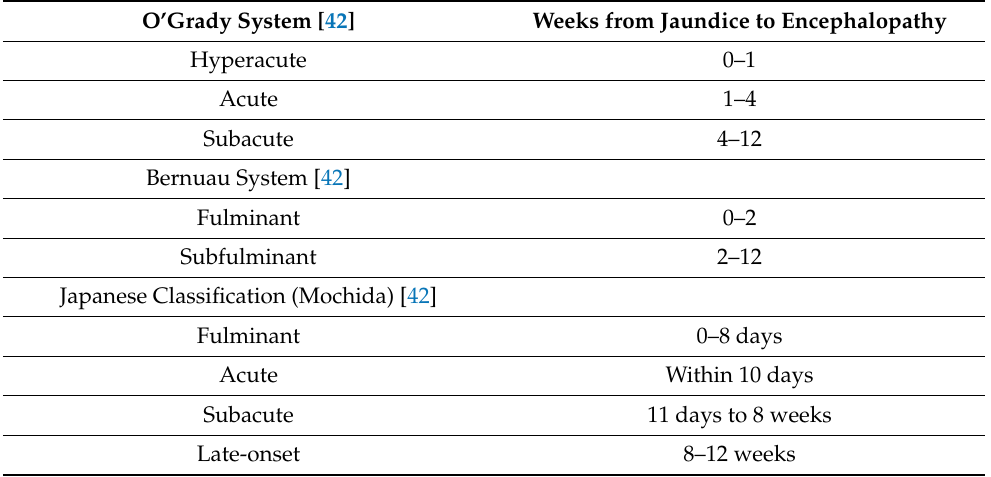
Table 4. Classification of ALF based on the interval between onset of jaundice and